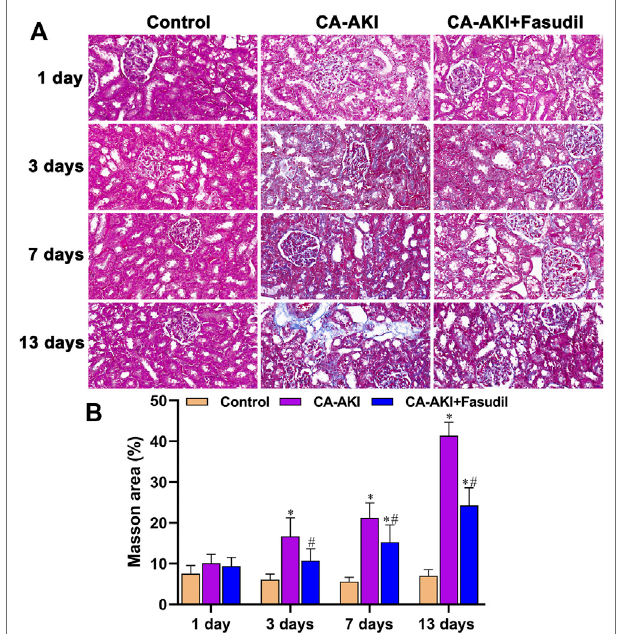
FIGURE 7 | Masson stains of renal fi brosis in three animal groups: (A) Appraisalofrelativerenal fi brosisextent(stainedblue); (B) Masson ’ strichrome staining scores.* p < 0.05 between CA-AKI/CA-AKI + Fasudil and controls; # p < 0.05 between CA-AKI + Fasudil and